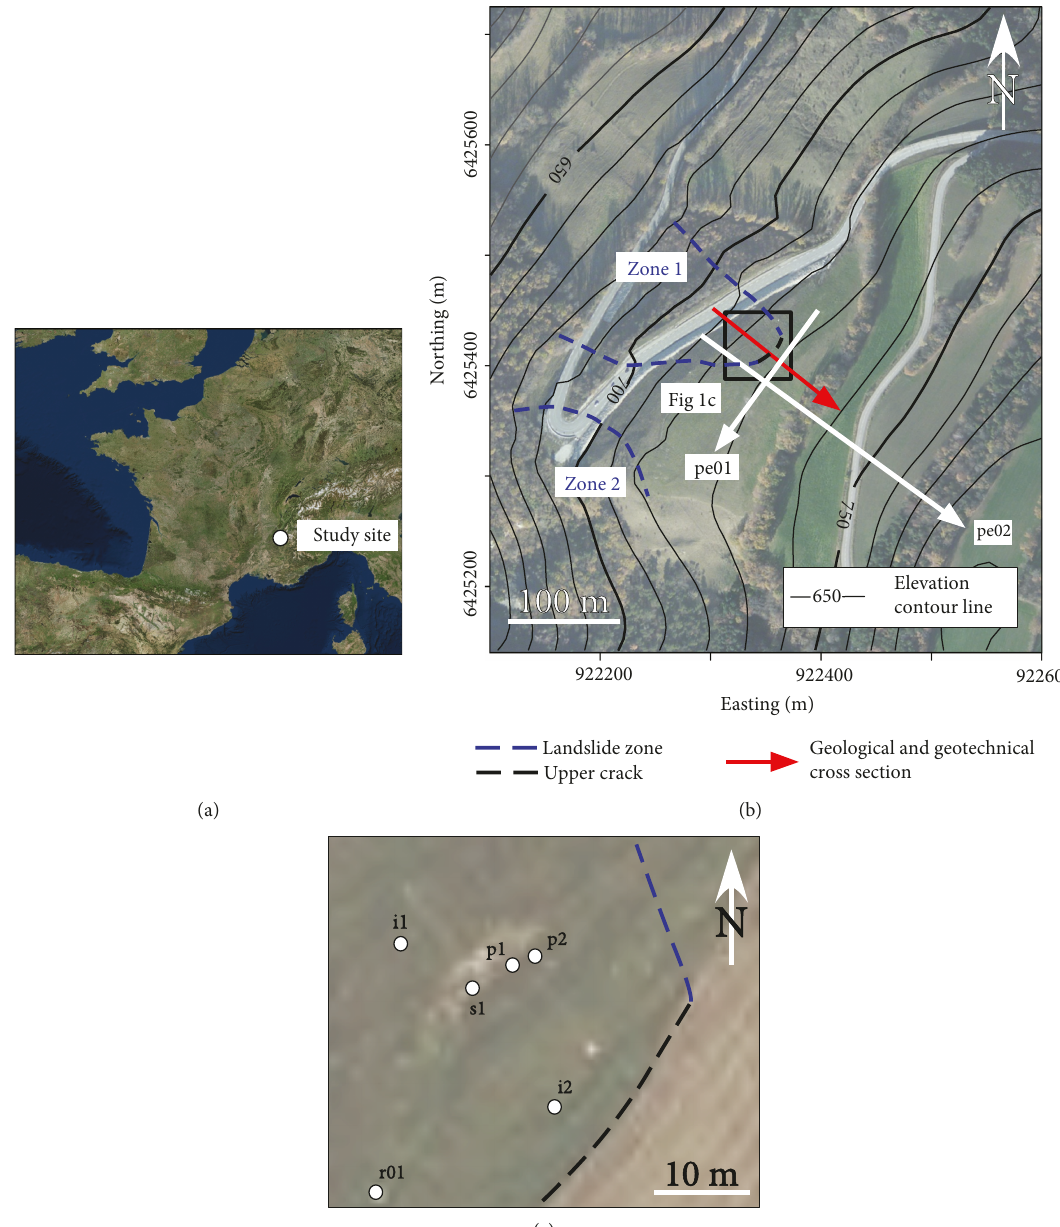
Figure 1: Location of the study site and of the tests. (a) General location. (b) Detailed morphology and location of the tests. pe01 and pe02 are electrical resistivity pro fi les. The red arrow represents the geological and geotechnical cross sections used in Figure 11. The black rectangle represents the location of Figure 1(c). Coordinates are metric and expressed in the French Lambert93 system. (c) Close-up on the location of inclinometers (i1 and i2), piezometers (p1 and p2), coring s1, and geodetic station